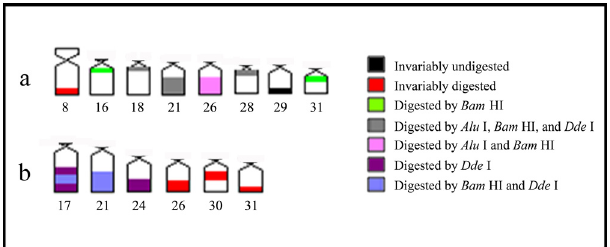
Fig. 5. Representative ideogram of chromosomal pairs in Hypostomu s cf. wuchereri showing the banding pattern after digestion using Alu I, Bam HI, Hae III, and Dde I. ( a ) population from Una River, ( b ) population from Mutum